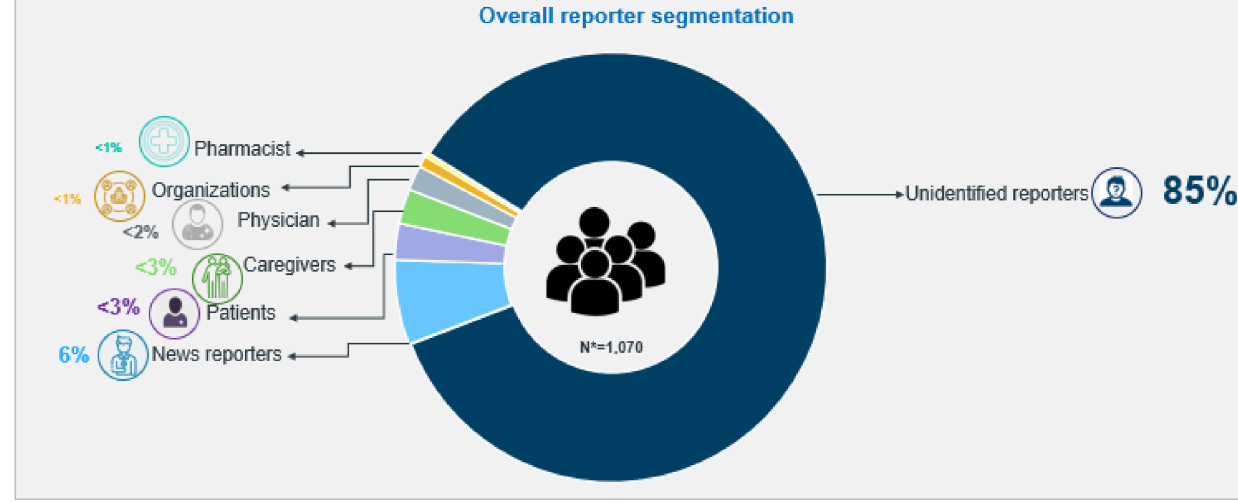
Figure 6. Overall reporter